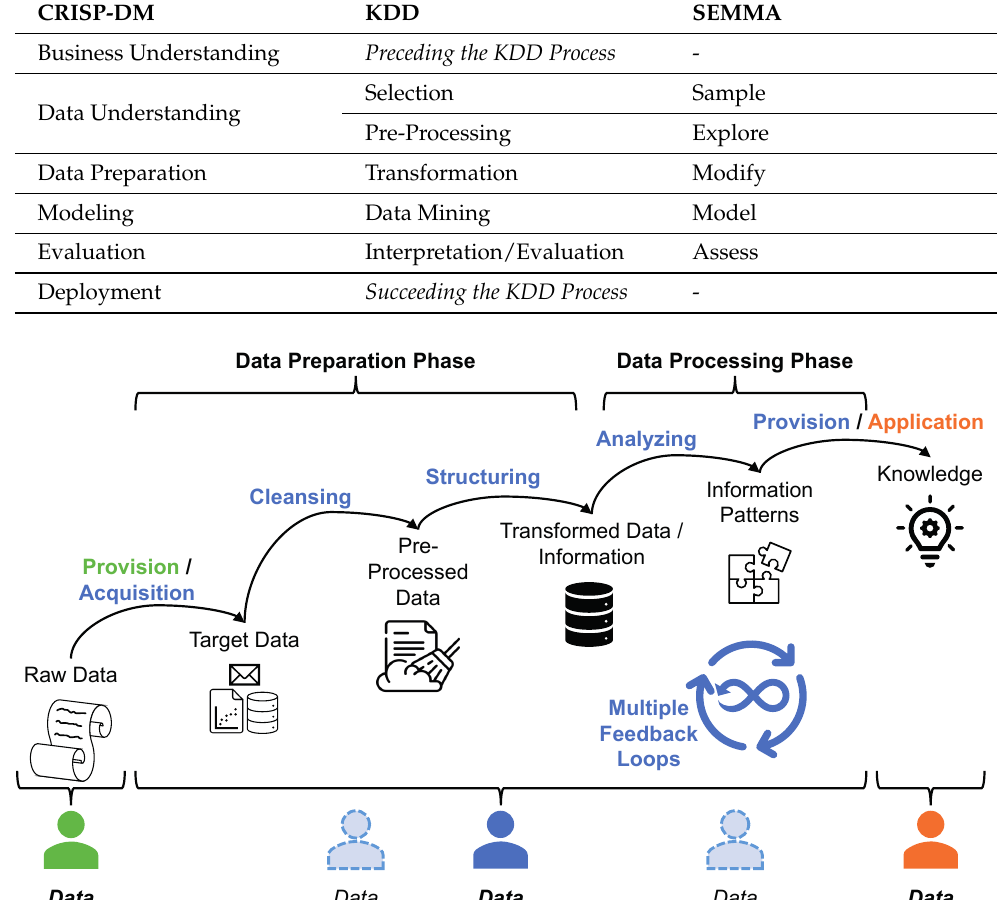
Table 1. Contrasting Juxtaposition of the Individual Process Steps of CRISP-DM, KDD, and SEMMA. CRISP-DM